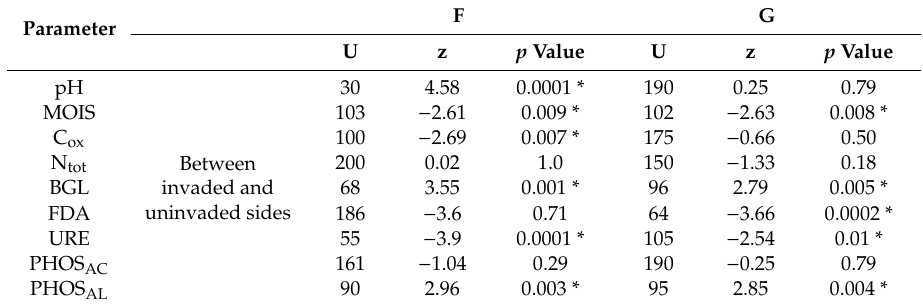
Table 3. The values of Mann–Whitney nonparametrical test for comparison soil characteristics between invaded and uninvaded sites in grassland (G) and forest (F) ecosystem, regardless of the year. F G Parameter U z p Value U z p Value pH 30 4.58 0.0001 * 190 0.25 0.79 MOIS 103 − 2.61 0.009 * 102 − 2.63 0.008 * C ox 100 − 2.69 0.007 * 175 − 0.66 0.50 N tot 200 0.02 1.0 150 − 1.33 0.18 Between invaded and BGL 68 3.55 0.001 * 96 2.79 0.005 * uninvaded sides FDA 186 − 3.6 0.71 64 − 3.66 0.0002 * 55 − 3.9 161 − 1.04 90 2.96 2.85 0.004